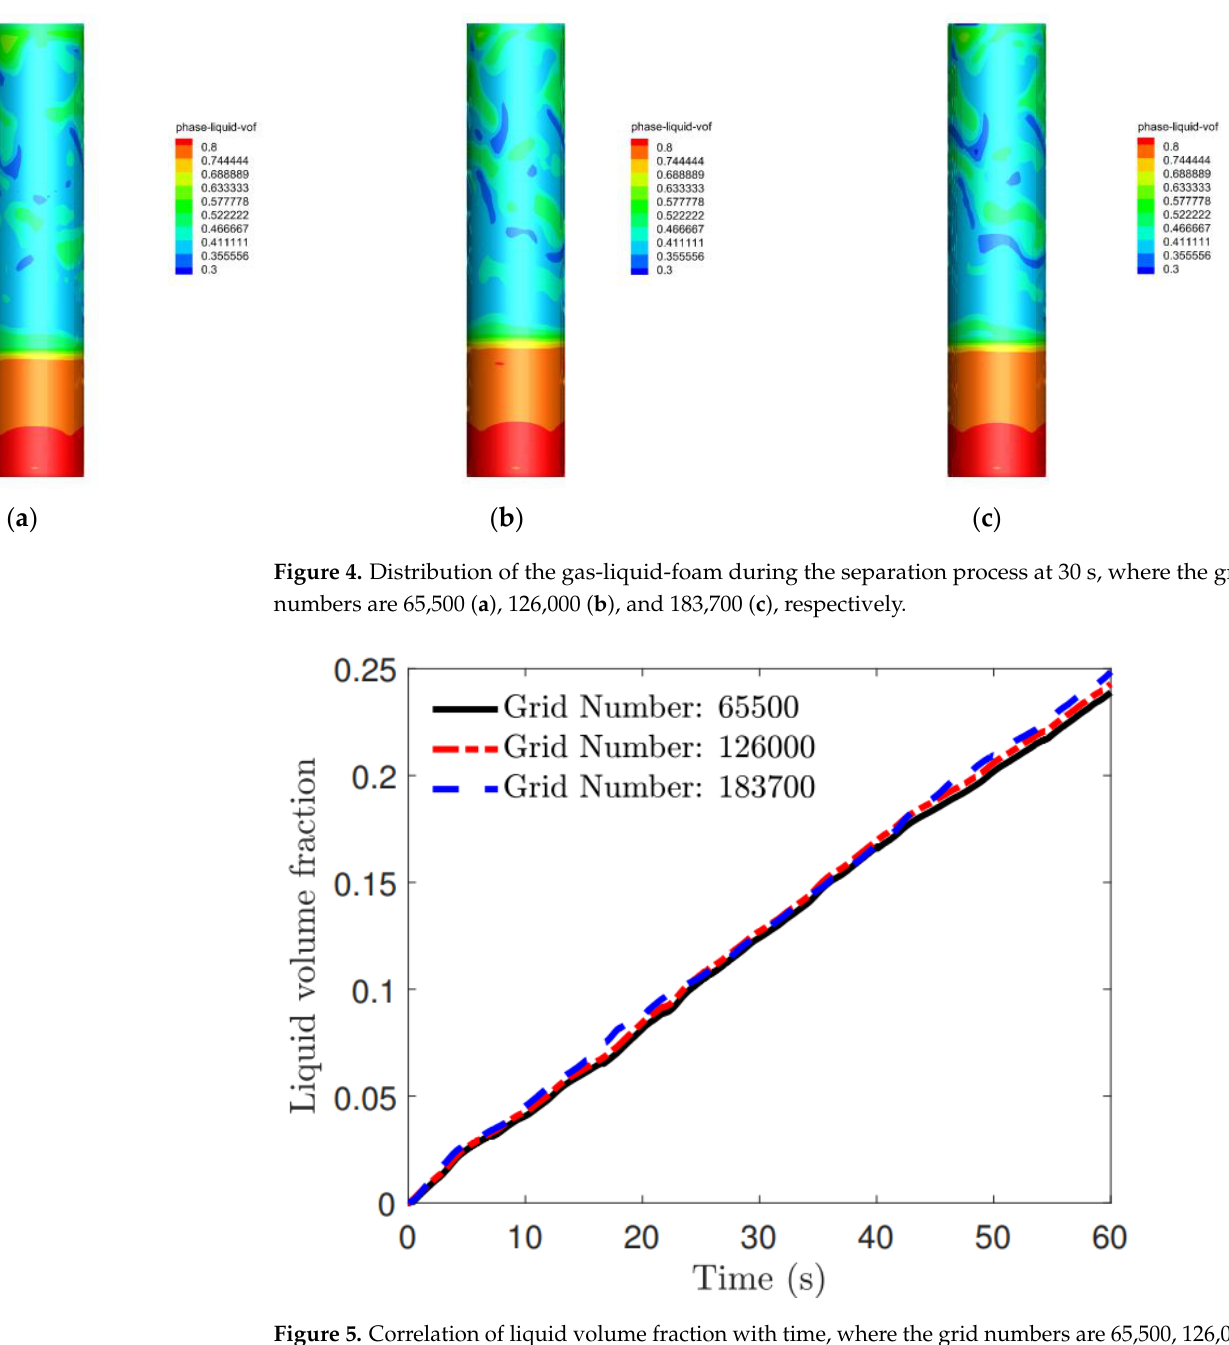
Figure 5. Correlation of liquid volume fraction with time, where the grid numbers are 65,500, 126,000, and 183,700, respectively.